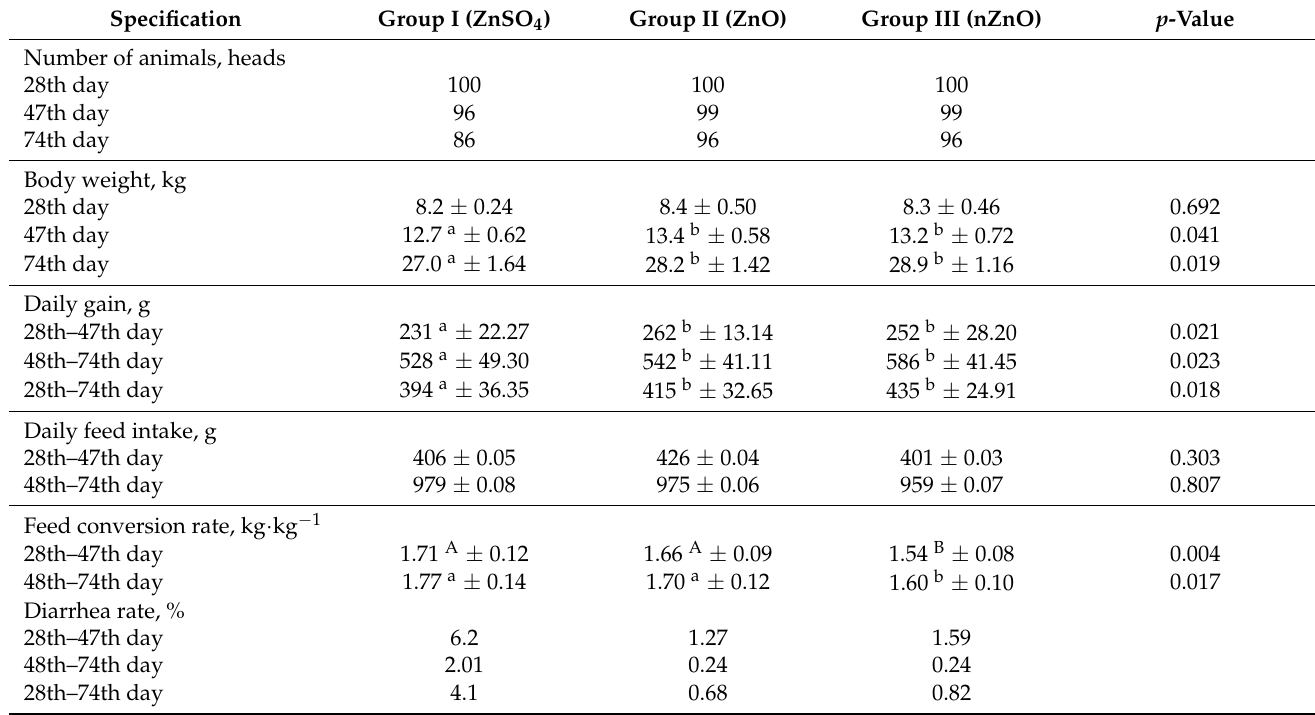
Table 3. Production results and diarrhea